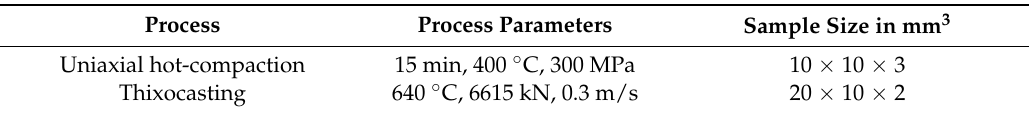
Table 1. Process parameters and sample sizes about the manufacturing route of the used AlSi6Cu4